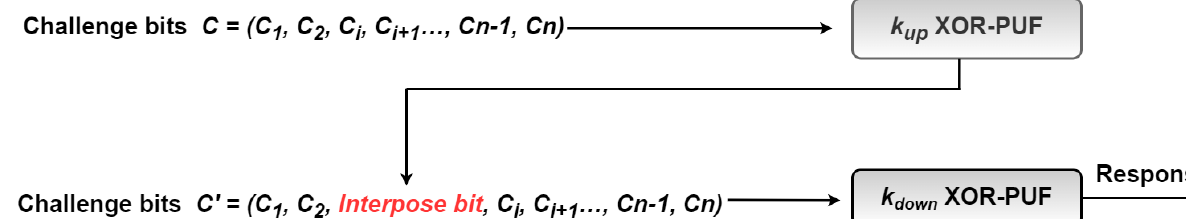
Figure 3. Schematic representation of Interpose